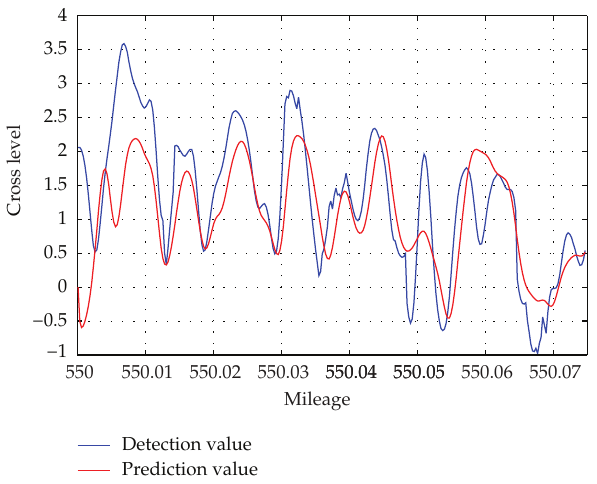
Figure 10: Comparison of detection value and the prediction value (cid:2) ANN (cid:3)